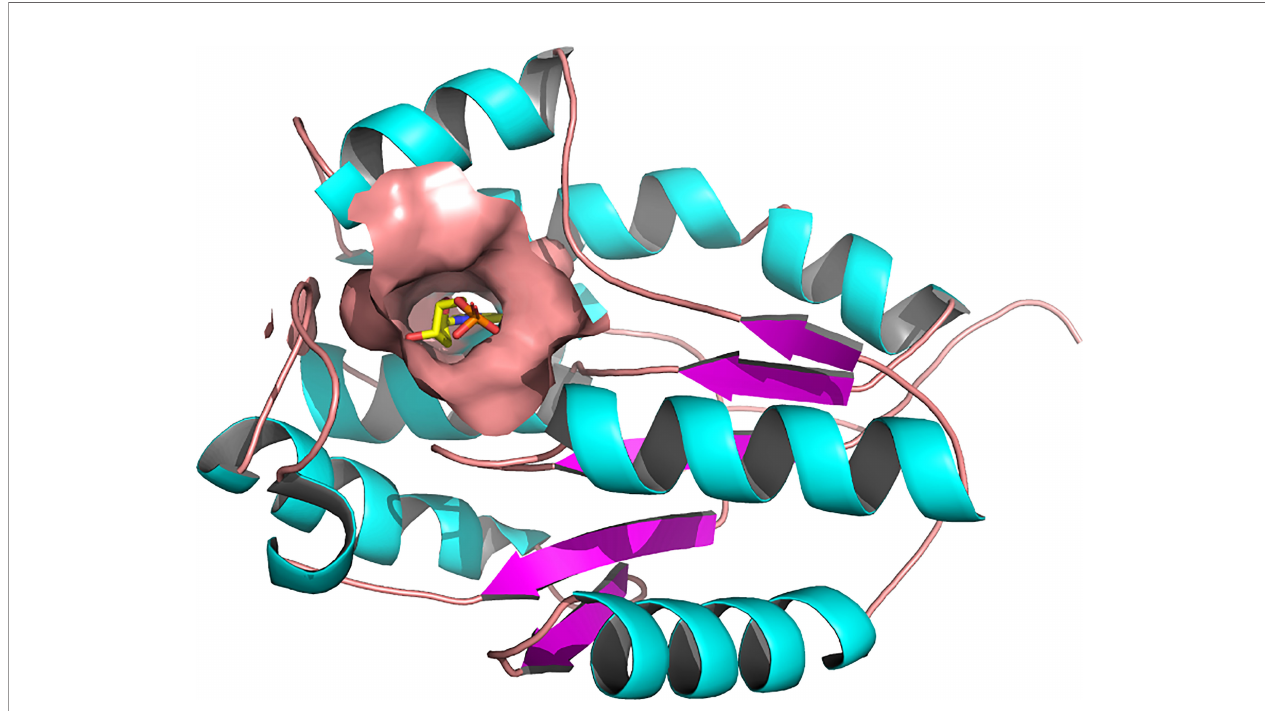
FIGURE 1 | Three-dimensional structure of Plasmodium falciparum thymidylate monophosphate kinase (PDB ID: 2WWF) and its active site (Whittingham et al., 2010). A cartoon representation of the 3D structure of Pf TMPK. The surface representation shows the active site of Pf TMPK and binding in its natural substrate, thymidine monophosphate (TMP), represented by yellow sticks. Active site residues include Asp17, Lys21, Leu59, Phe44, Arg47, Pro45, Phe74, Arg78, Arg99, Tyr100, Ser103, Gly104, Tyr107, and Tyr153 (Kandeel et al., 2009). The protein structure was retrieved from the Protein Data Bank, and image was generated with